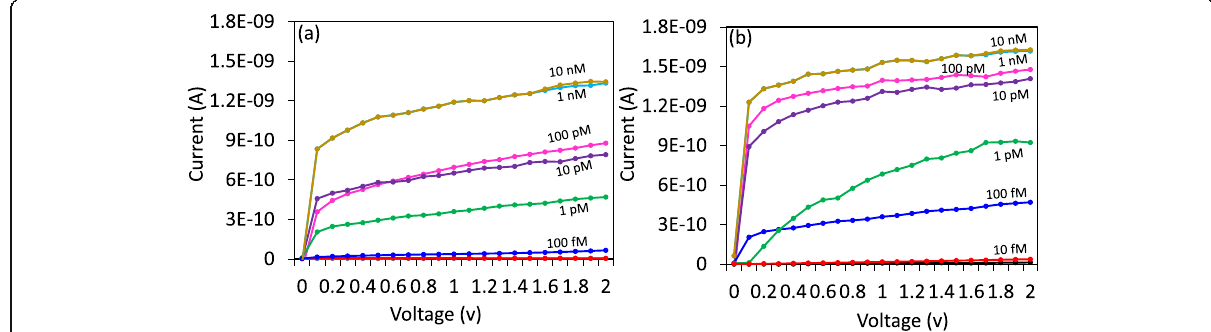
Fig. 5 Dose-dependent interactions with a antibody and b GNS antibody on IDE-TiO 2 surfaces. The surface is with the above steps until 1 M of ethanolamine blocking. A linear sweep voltage of 0 to 2 V at 0.01 V step voltage was followed for the measurements. SCC-Ag concentrations from 10 fM to 10 nM interacted on both surfaces, and the current changes were noticed. Washing was performed by five reaction volumes at each step using 10 mM PBS (pH 7.4). With an increase in SCC-Ag concentrations, the current levels were gradually increased in both cases. GNS antibody shows the current changes from 10 fM, while changes from 100 fM were noticed with only antibody. In both cases (antibody and GNS antibody), 1 nM SCC-Ag displayed the saturation. When the concentration is increased further, any significant changes in the current could not be